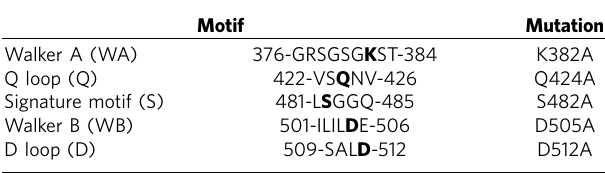
The bold entries indicate point of